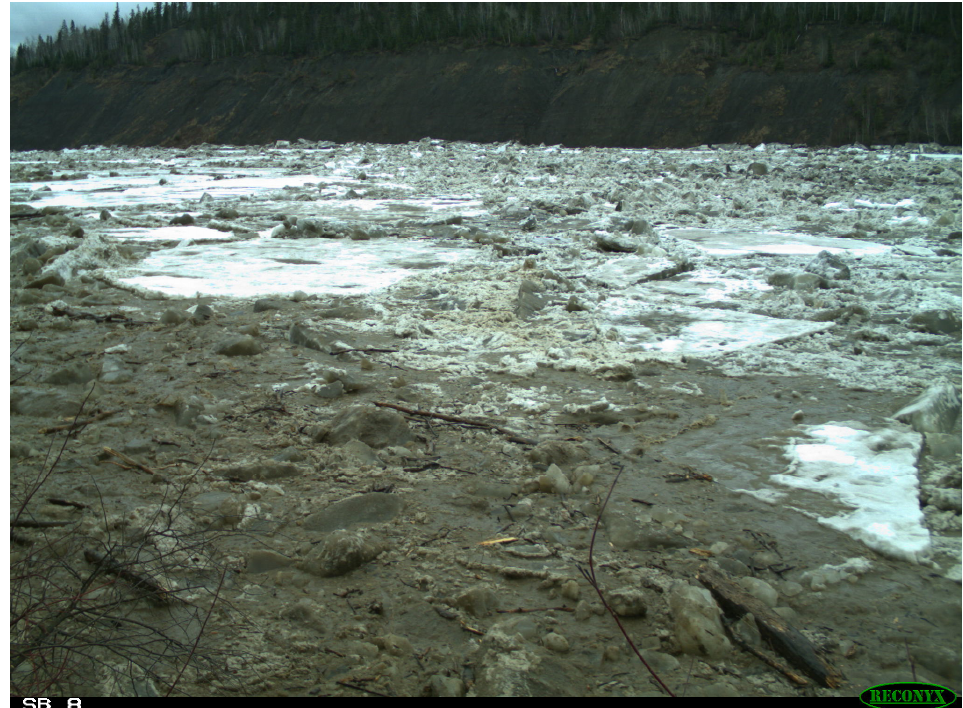
Figure 4. Early phase of ice run near Fort McMurray Golf Course, 27 April 2014. Photo taken by time-lapse camera installed on the left (north) river bank and looking across and slightly downstream. The water surface is exposed in the lower left portion of the image. Local river width ~400 m. From [18], Crown copyright, published by Elsevier.